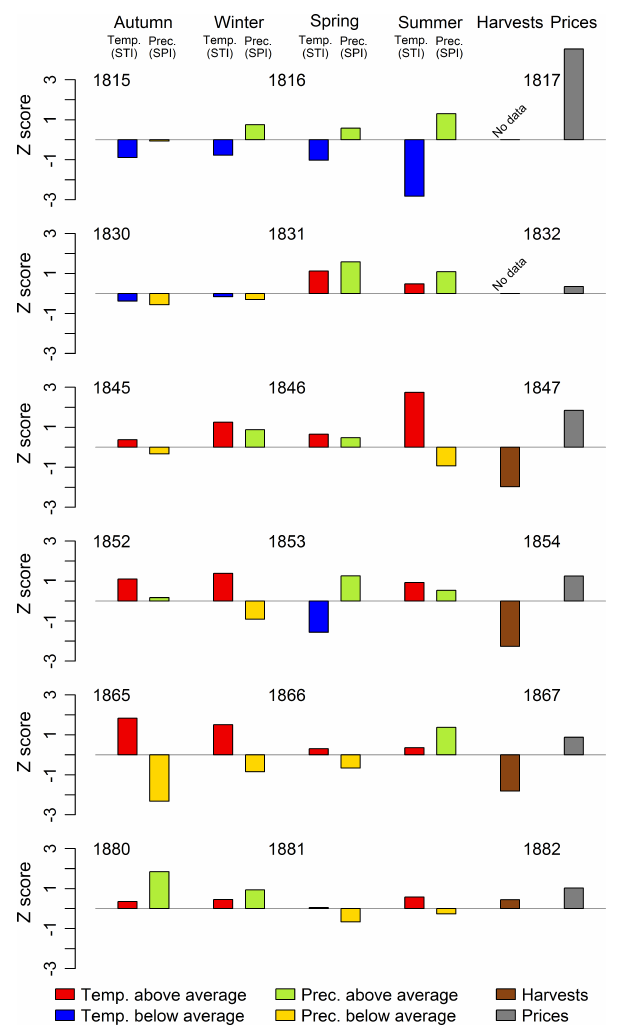
Figure 7. Z scores of seasonal temperatures (STI), precipitation (SPI), harvests and prices of the peak years of emigration from Württemberg between 1816 and 1886. Z scores indicate the pro- portion of standard deviation from the long-term